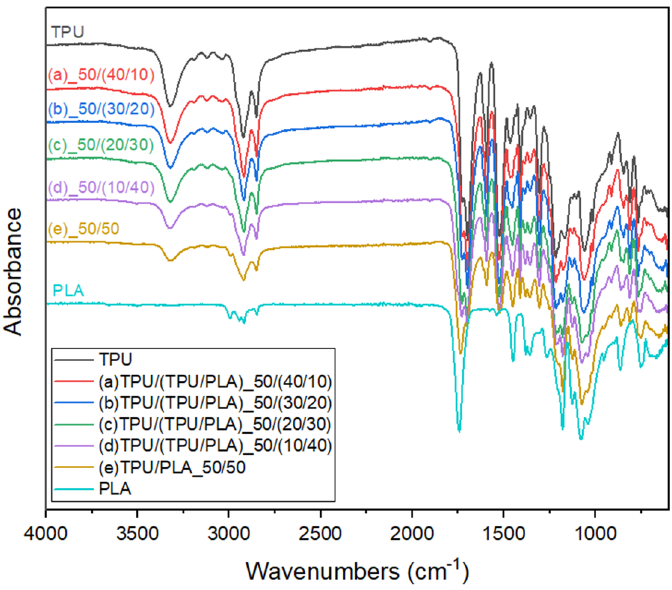
Figure 8. FT − IR spectra of TPU/(TPU/PLA) side − by − side bicomponent fibers ((a)–(e)), pure TPU, and PLA fibers. and PLA